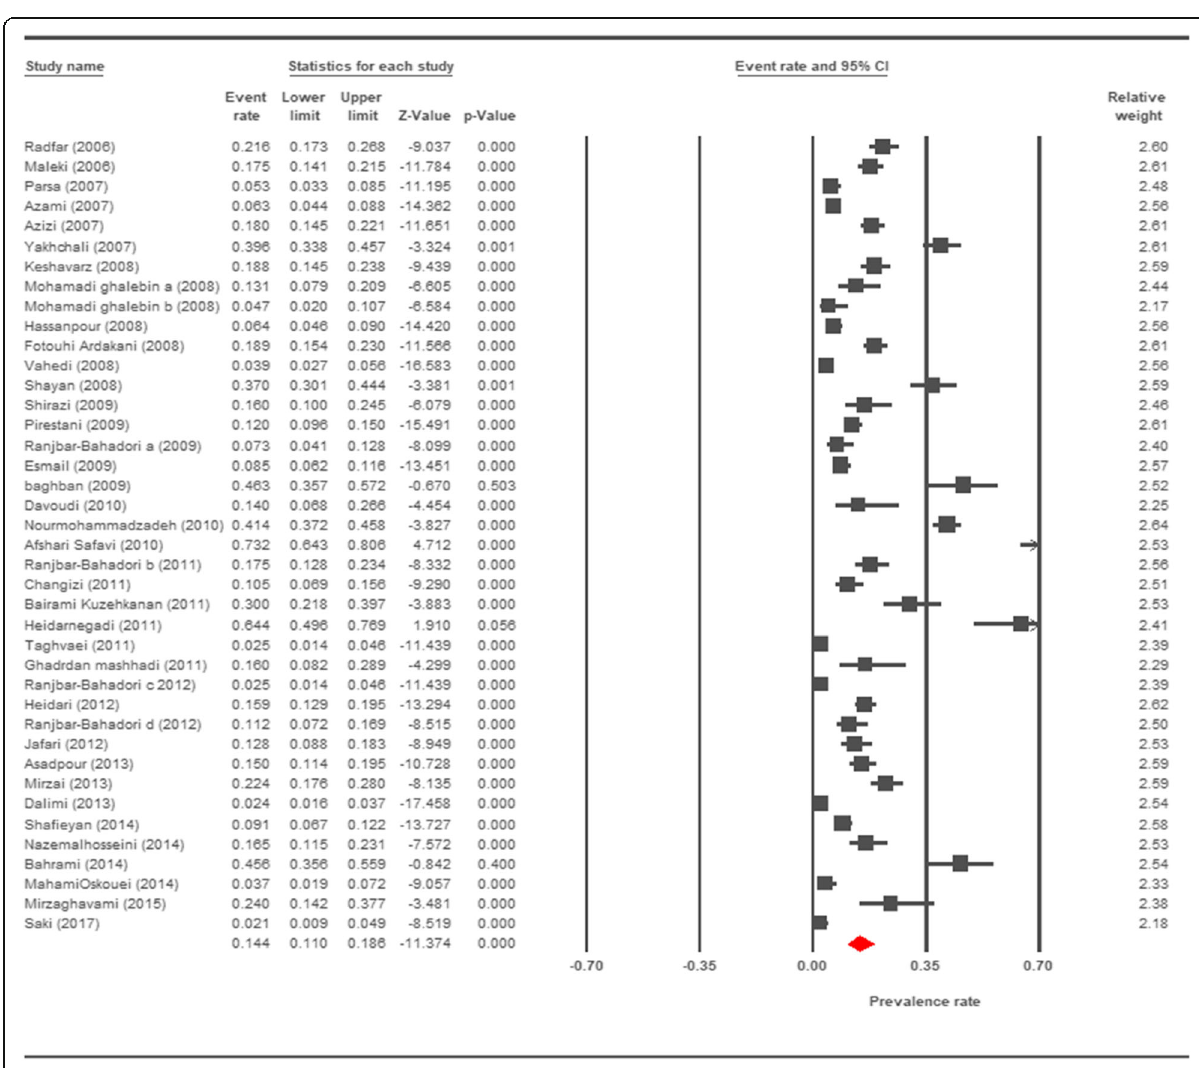
Fig. 7 Forest plot diagram showing the prevalence rate of Cryptosporidium infection in cattle of